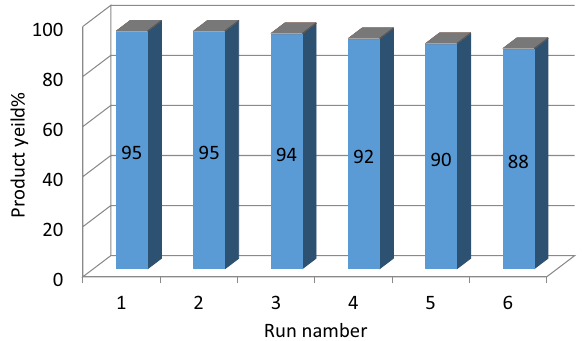
Figure 11. Recycling of Fe 3 O 4 @Glycerol-Cu in the construction of 2-amino-4 H -chromene.